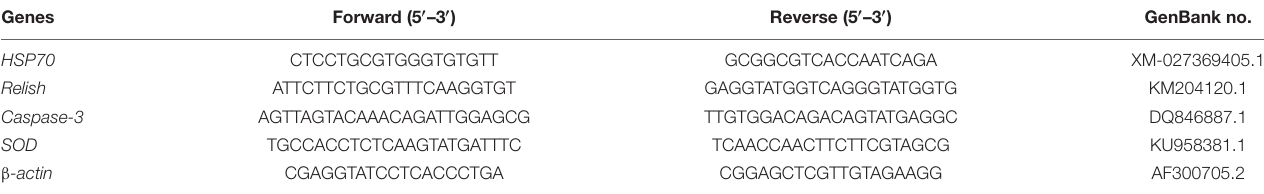
TABLE 2 | Sequences of primers used in this study.